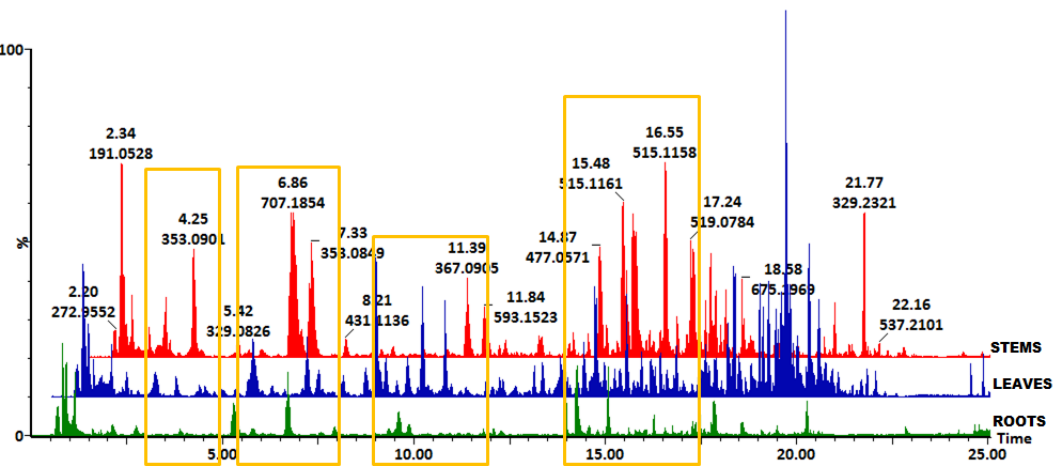
Figure 1. Representative UHPLC ‐ QTOF ‐ MS base peak intensity (BPI) chromatograms showing the separation of secondary metabolites in extracts of B. pilosa roots (green), leaves (blue), and stems (red). The yellow rectangles indicate the chromatographic regions where hydroxycinnamic acid derivatives are present across the three tissue types with some visible differences in intensities.